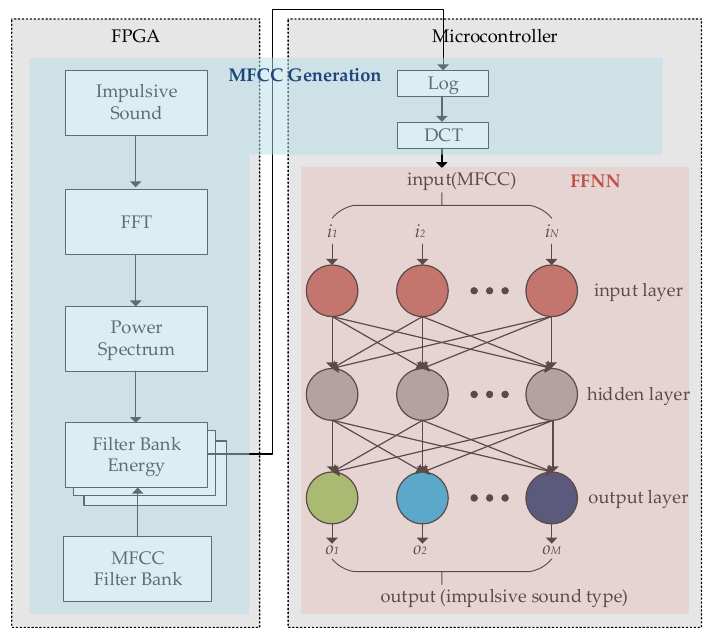
Figure 3. The MFCC-FFNN scheme using MFC (implemented by FPGA) as an input to FFNN (implemented by microcontroller). Table 1. Parameters of the MFCC-FFNN